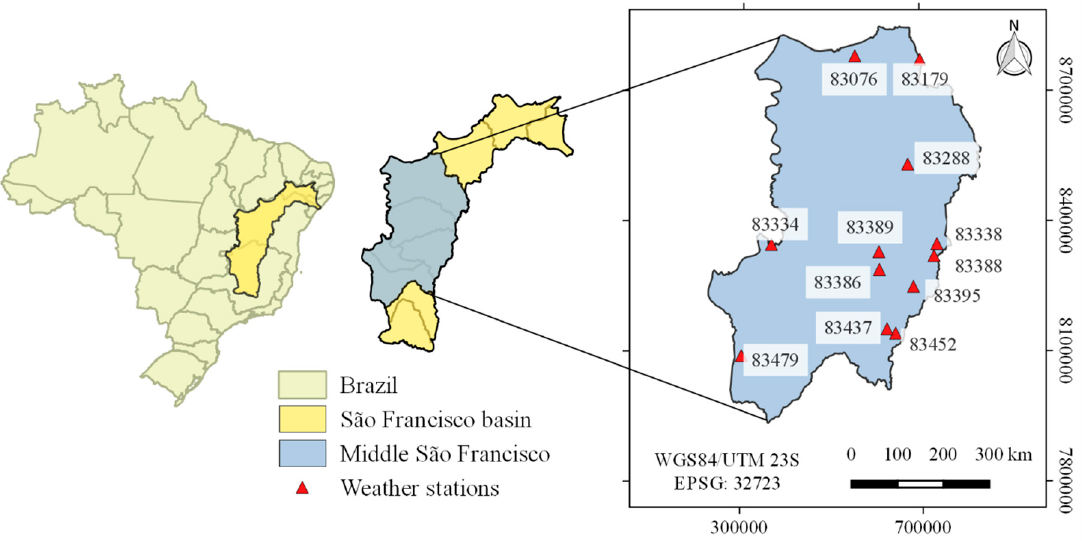
Figure 1. Location of study area and weather stations in relation to the São Francisco Basin and Brazil.